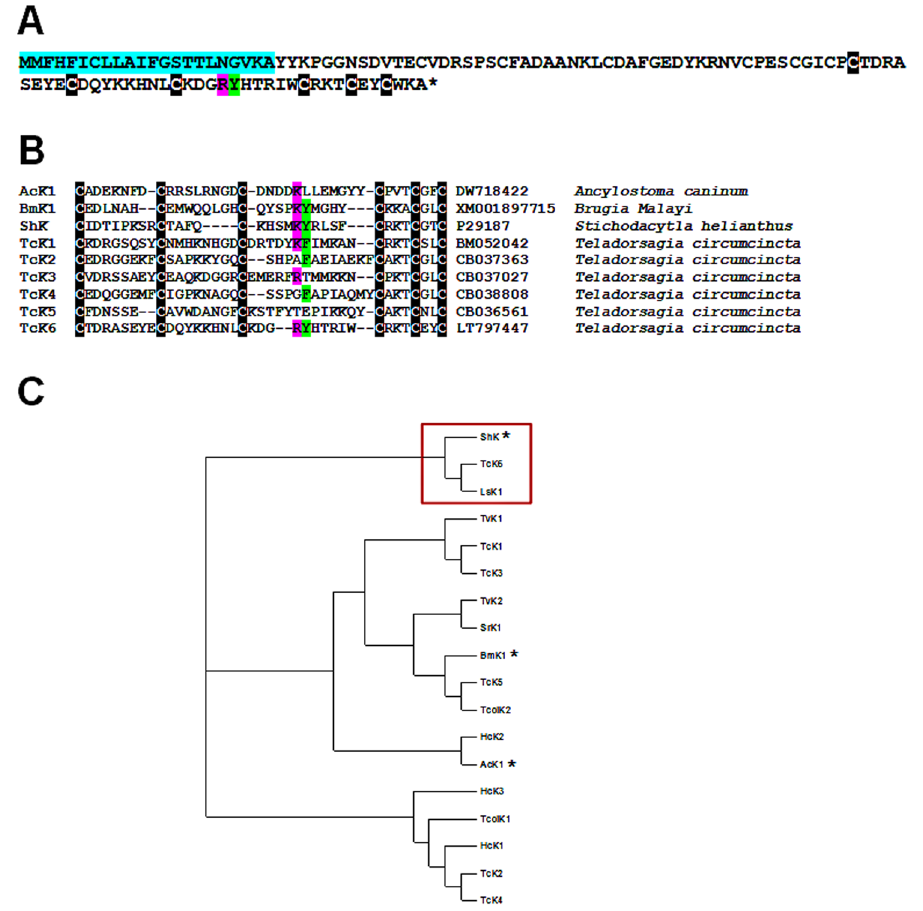
Figure 4. Predicted animo-acid sequence of TcK6 and relationship of TcK6 ShKT domain with those from related proteins from a variety of eukaryotic organisms. ( A ) Full-length coding sequence of TcK6. Signal peptide is indicated in blue. ( B ) Alignment of ShKT domain amino acid sequences from Ancylostoma caninum (AcK1), Brugia malayi (BmK1), Stichodactyla helianthus (ShK) and Teladorsagia circumcincta (TcK1-6). For panels (A) and (B), conserved cysteines are highlighted in black, the K/R residue which is critical for Kv1.3 channel inhibition is highlighted in magenta and the neighbouring aromatic residue (F or Y) highlighted in green. ( C ) Alignment of 35–40 amino acid residue ShKT domains derived from EST or protein depositions in public databases with TcK6 using ClustalX (version 2.0.10). A relationship tree was constructed using